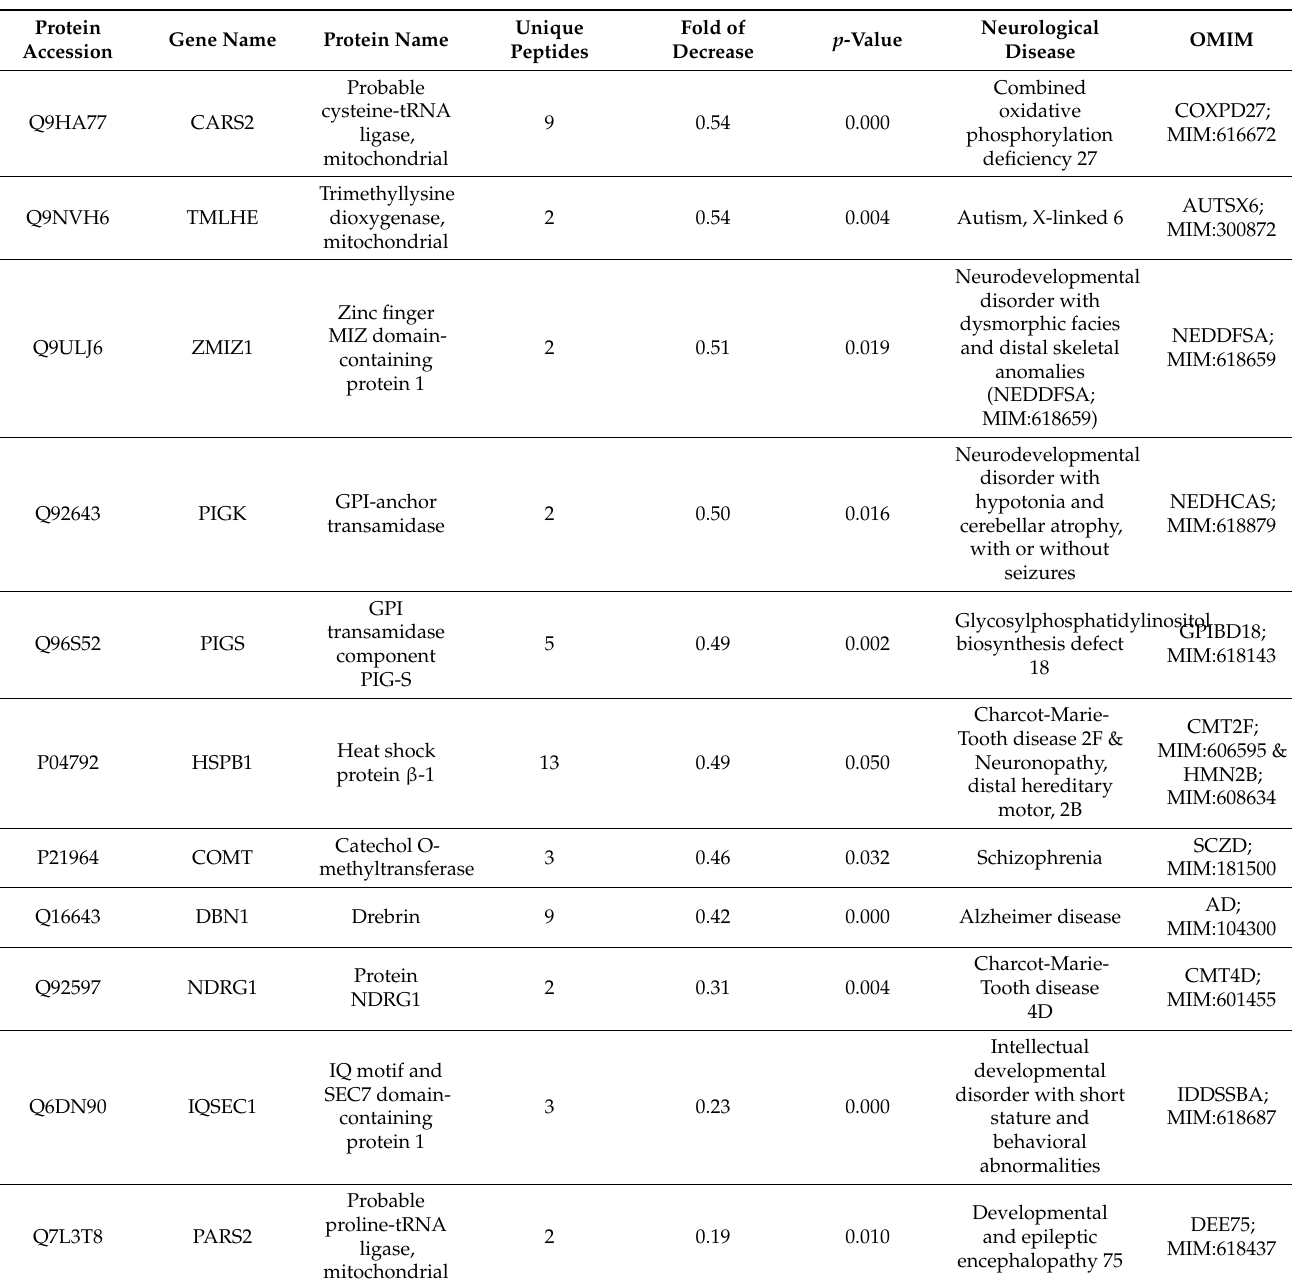
Table 1. Proteins decreased in the proteomic signature of p.(A20S)-SPTLC1-mutant lymophoblastoid cells associated with neurological